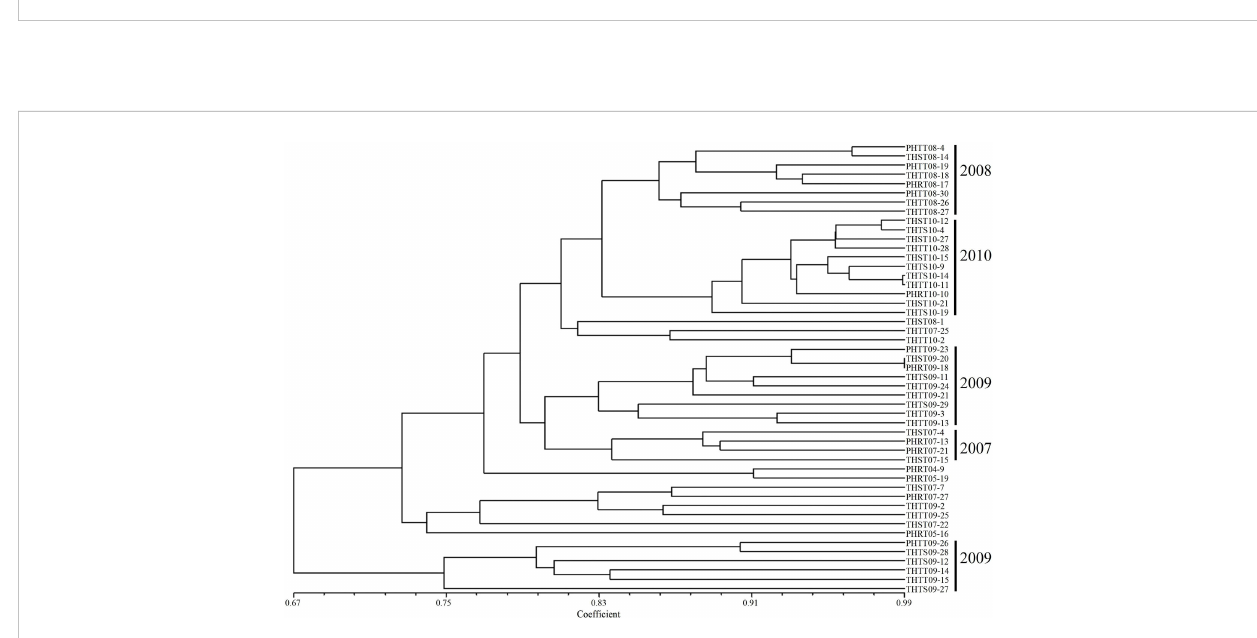
MXCOMPmoduleofNTSYS-pc.Theseresultsindicatedacorrelation